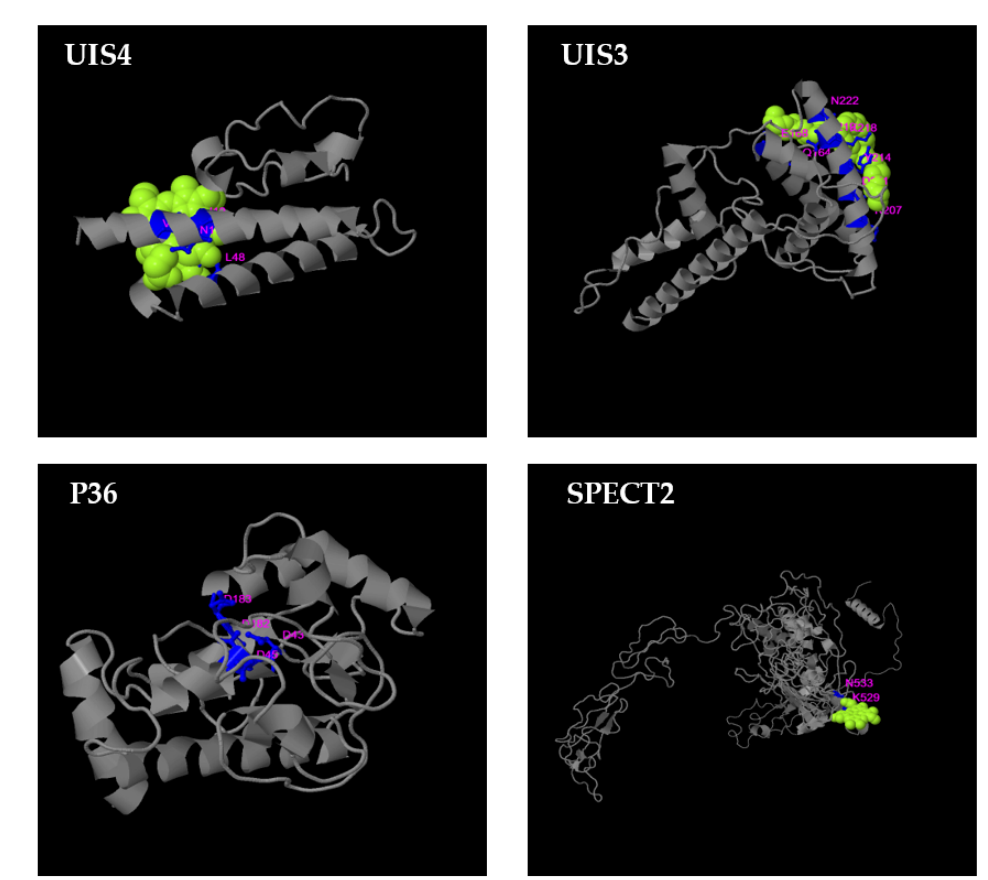
Figure 4. Predicted 3D structure of four malaria vaccine candidates with hypothetical protein–lig- and binding sites shown in light purple. binding sites shown in light